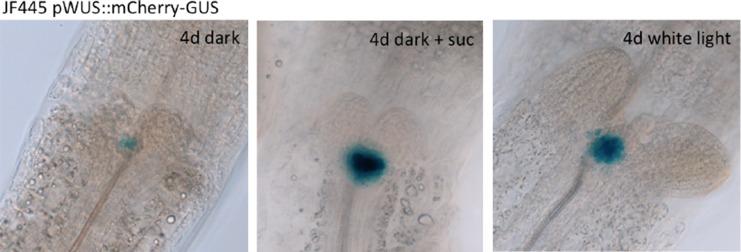
DOI:
http://dx.doi.org/10.7554/eLife.17023.015